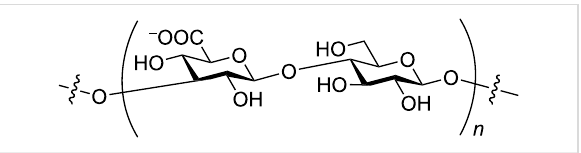
Figure 1: Disaccharide repeating unit of the S. pneumoniae serotype 3 CPS.